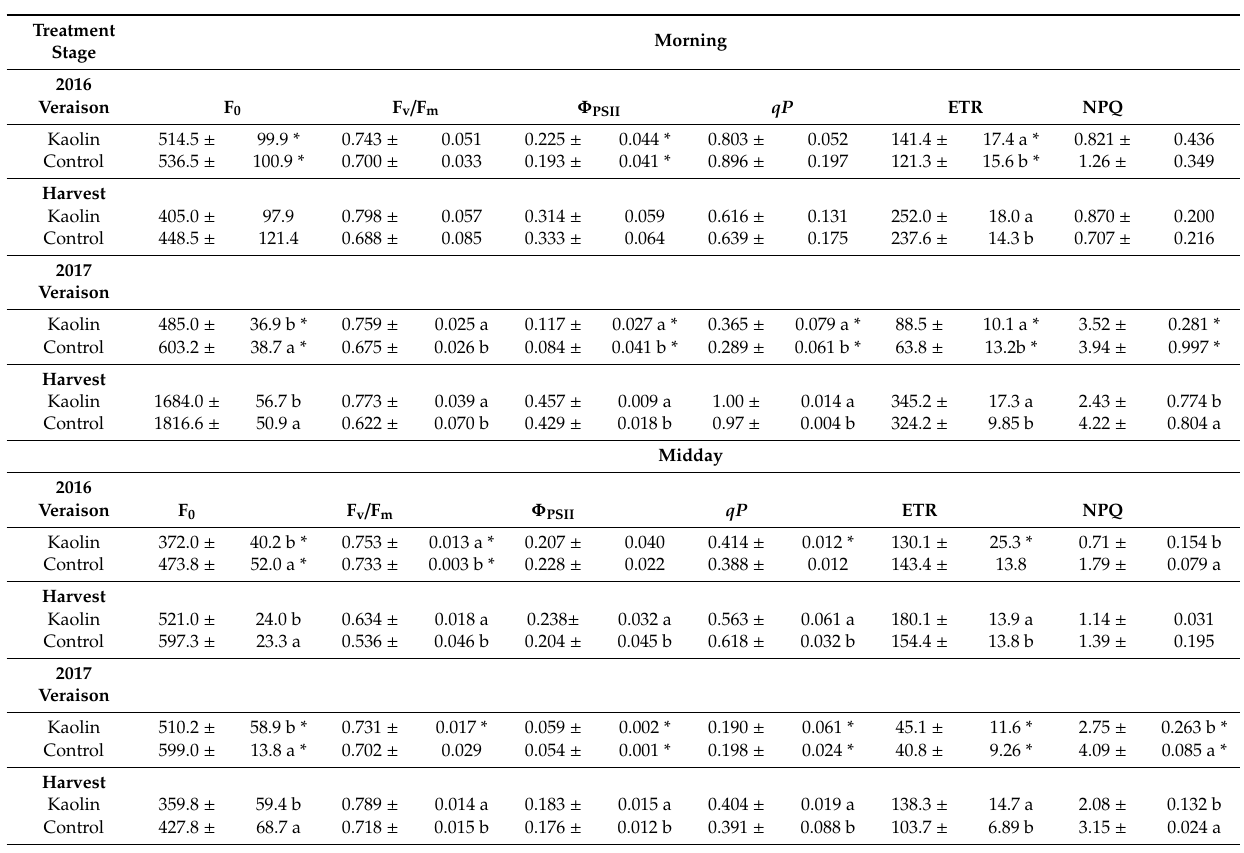
Table 2. Chlorophyll a fluorescence parameters, namely basal fluorescence (F 0 ), maximum quantum e ffi ciency of photosystem II (F v / F m ), e ff ective PSII e ffi ciency ( Φ PSII ), photochemical quenching ( q P), electron transport rate (ETR, µ mol e − m − 2 s − 1 ), and non-photochemical quenching (NPQ) at morning and midday periods in veraison and maturation stages in kaolin and control leaves ( n = 10). Di ff erent lowercase letters represent significant di ff erences between treatments (control vs. kaolin), in the same period of the day (morning / midday) within the stage of the season (veraison / maturation), and * represents significant di ff erences between stages of the season within the same period of the day ( p < 0.05). Absence of superscript indicates no significant di ff